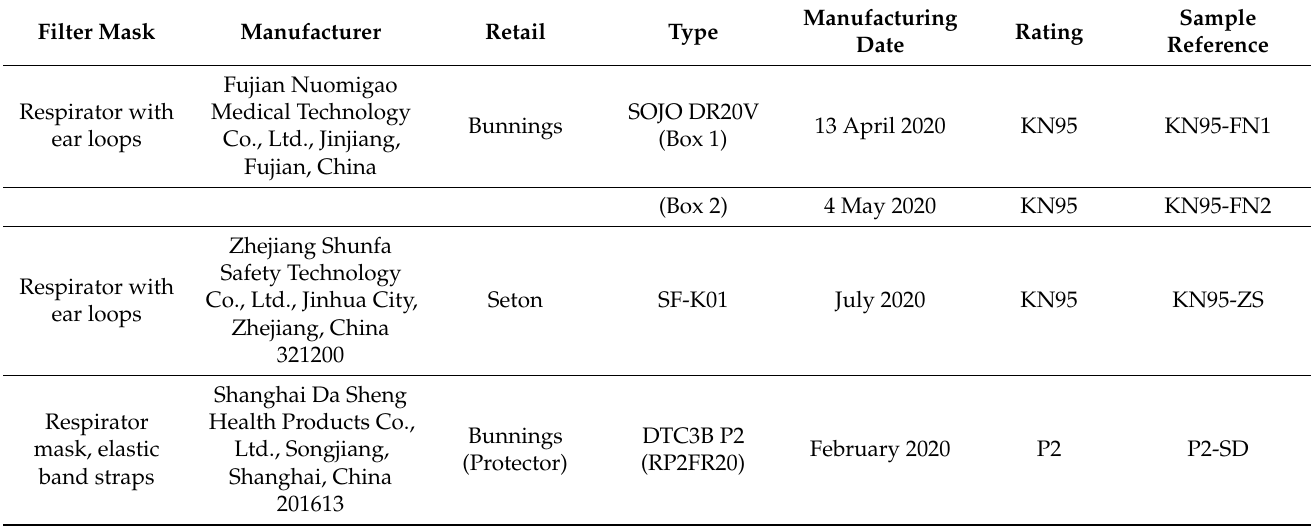
Table 1. Filter material description and